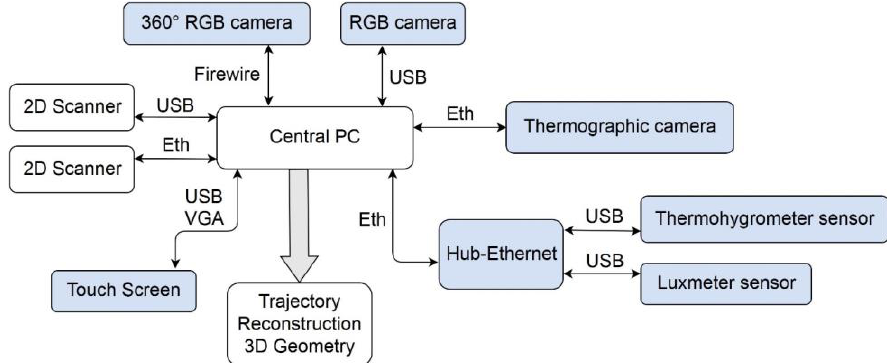
Figure 2. Connections scheme of the IMAS components.